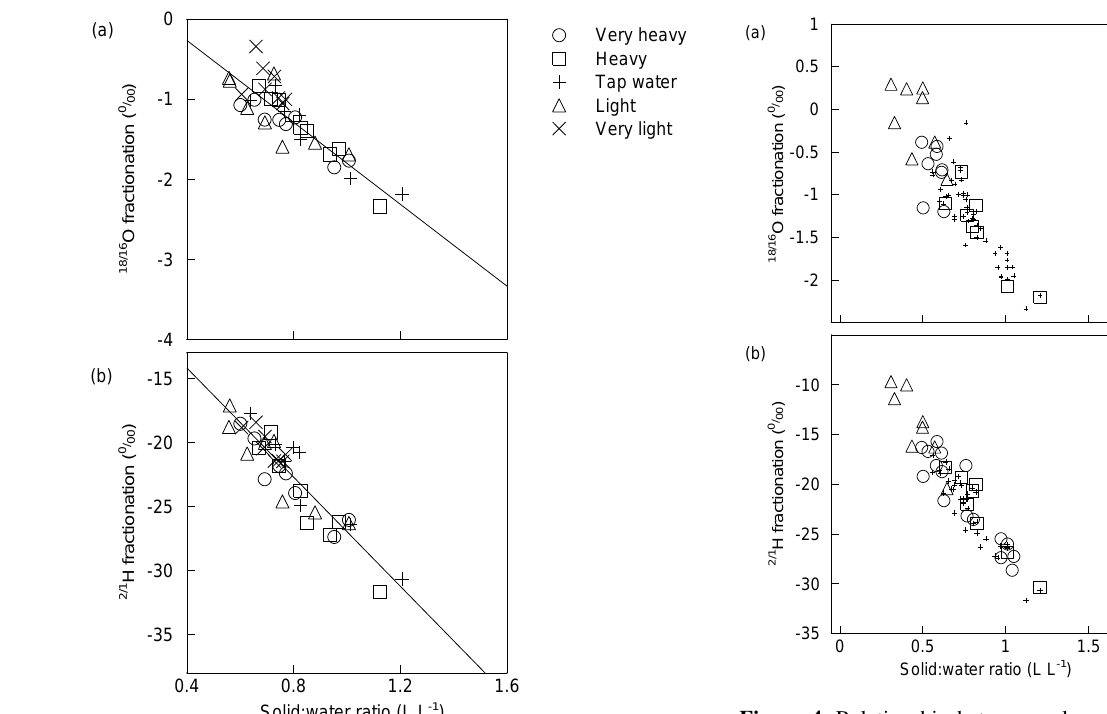
Figure 4. Relationship between volumetric solid:water ratio and the apparent isotopic fractionation of (a) 18 / 16 O and (b) 2 / 1 H be- tween unconfined water and total water adsorbed by silage with dif- ferent pretreatments ( N = 8 each). The data of Figs. 2 and 3 (both oven-dried silage, N = 32) are provided for